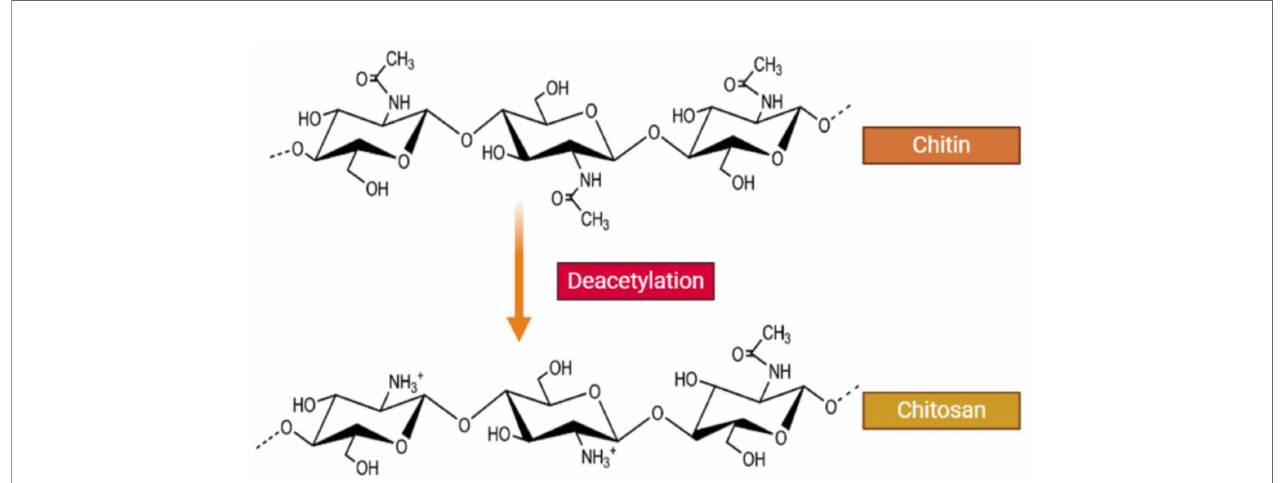
FIGURE 1 | Structure of chitin and chitosan. CH is a naturally occurring water-soluble cationic polysaccharide that is generated by alkaline deacetylation of chitin. CH is a linear polysaccharide composed of b – (1-4) linked 2-acetamide-2-deoxy-D-glucose (a neutral sugar unit GlcNAc or A-unit) and 2-amino 2-deoxy-D-glucose (a cationic sugar unit GlcN or D-unit). CH can have a broad range of degree of deactylation (F A ), as well as variable chain length and molecular